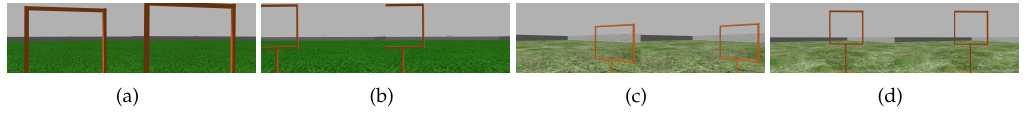
Figure 10. Mosaic image examples where each mosaic image ( a – d ) is composed of 2 frames.